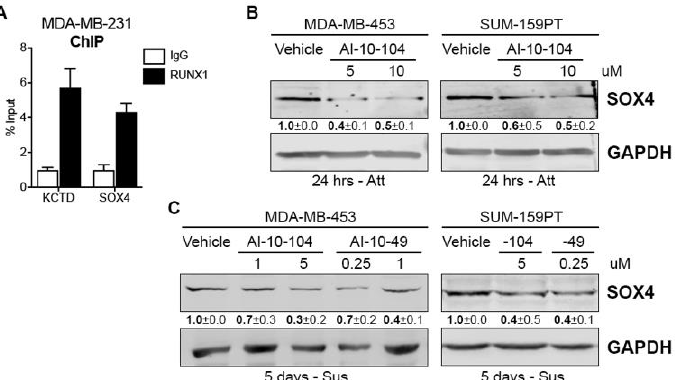
lines were cultured in forced suspension for 4 days and treated with RUNX1 inhibitors for 24 h, SOX4 protein was also downregulated (Figure 4C).